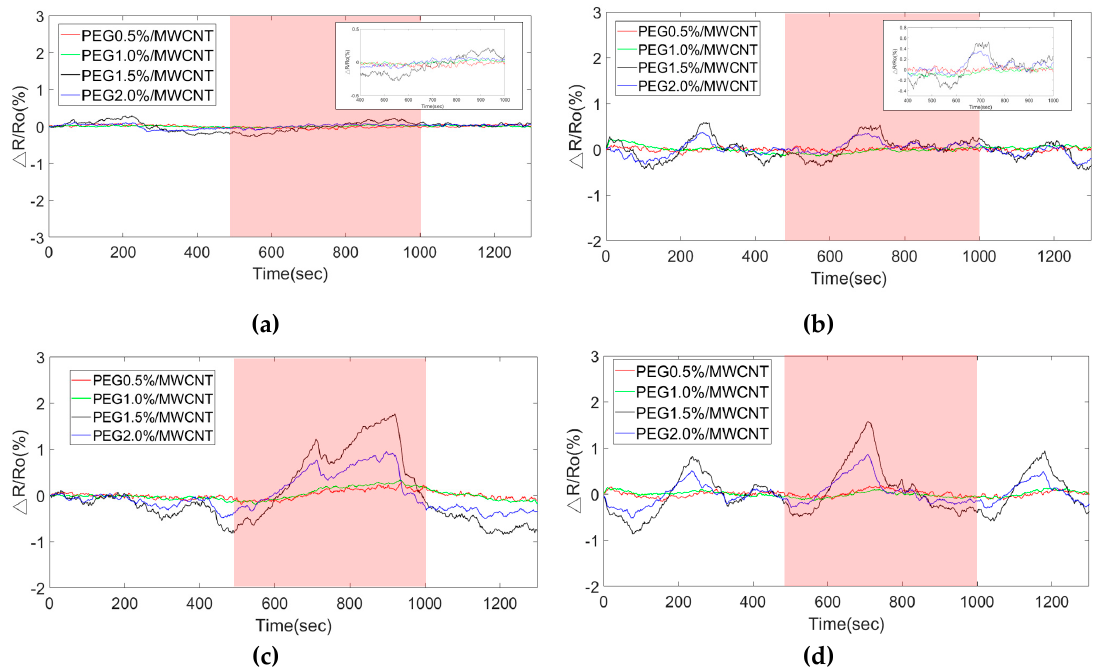
Figure 12. Response of sensor expsoure to 6294.3 ppm acetone at different operating